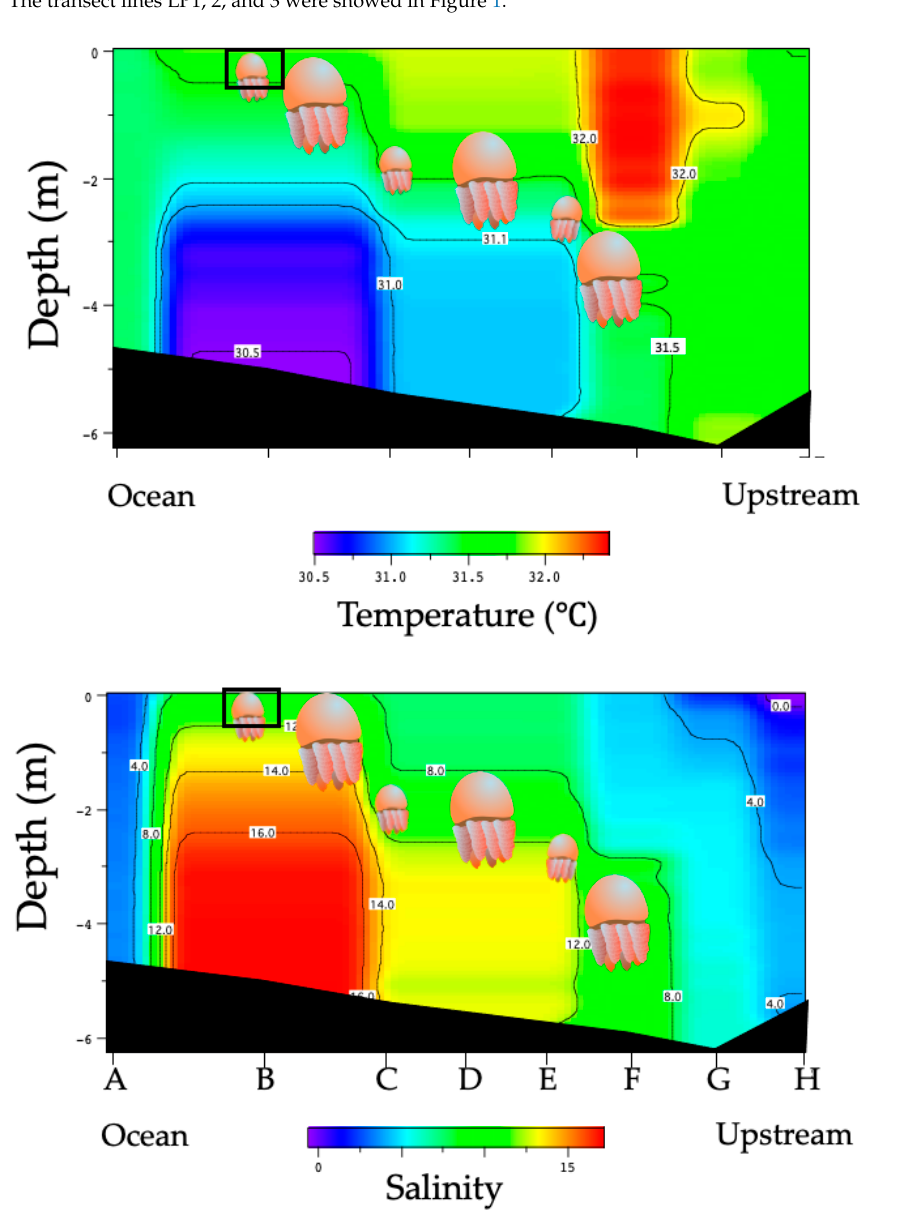
Figure 3. Profiles of temperature and salinity along LP4 in Perak River at low tide. Letters indicate places where CTD was cast, as shown in Figure 1. Black rectangle shows occurrence area of medusae along this transect survey. Possible jellyfish distribution in this survey is shown with jellyfish images. Table 1. Temperature and salinity at survey sites in Perak River.